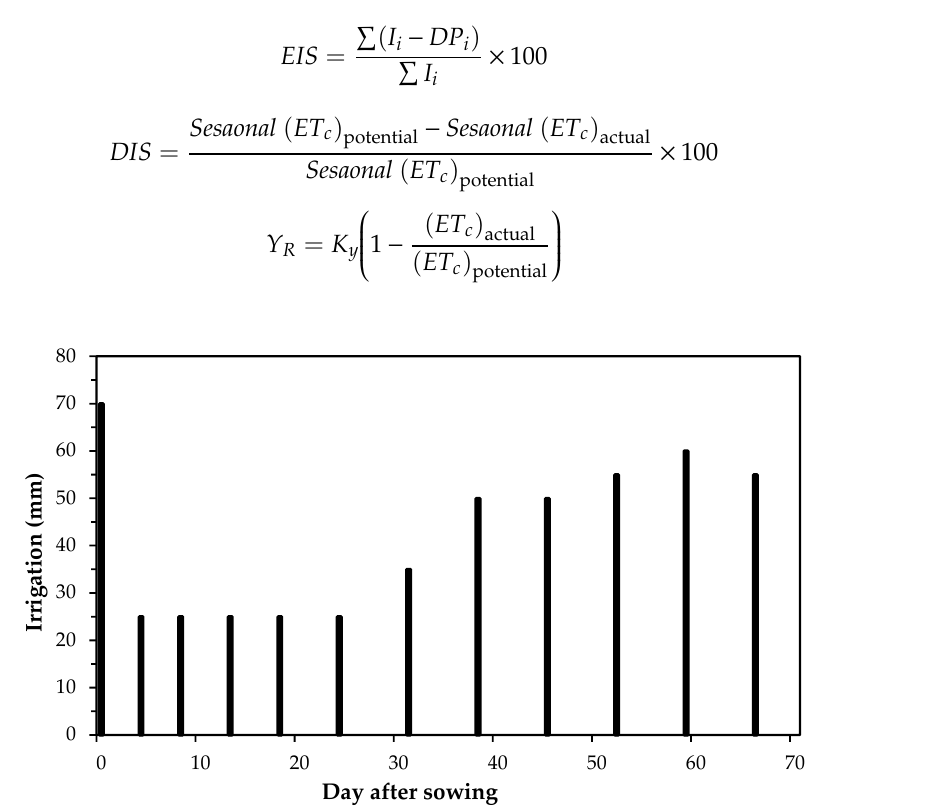
Figure 3. Amounts of irrigation water (mm) applied during the Jew’s Mallow growing season.